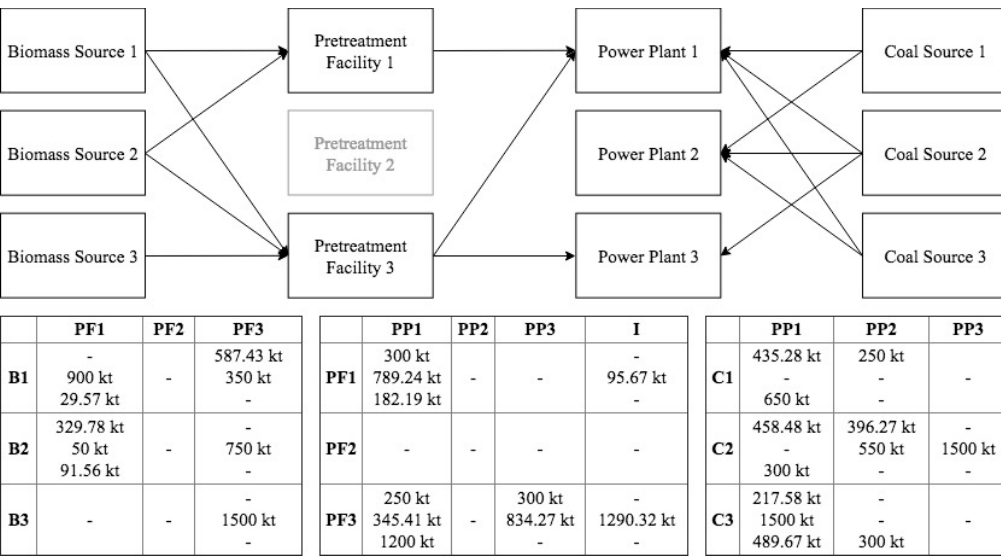
Figure 11. Optimal Network for Improved Biomass Properties in Period 2.